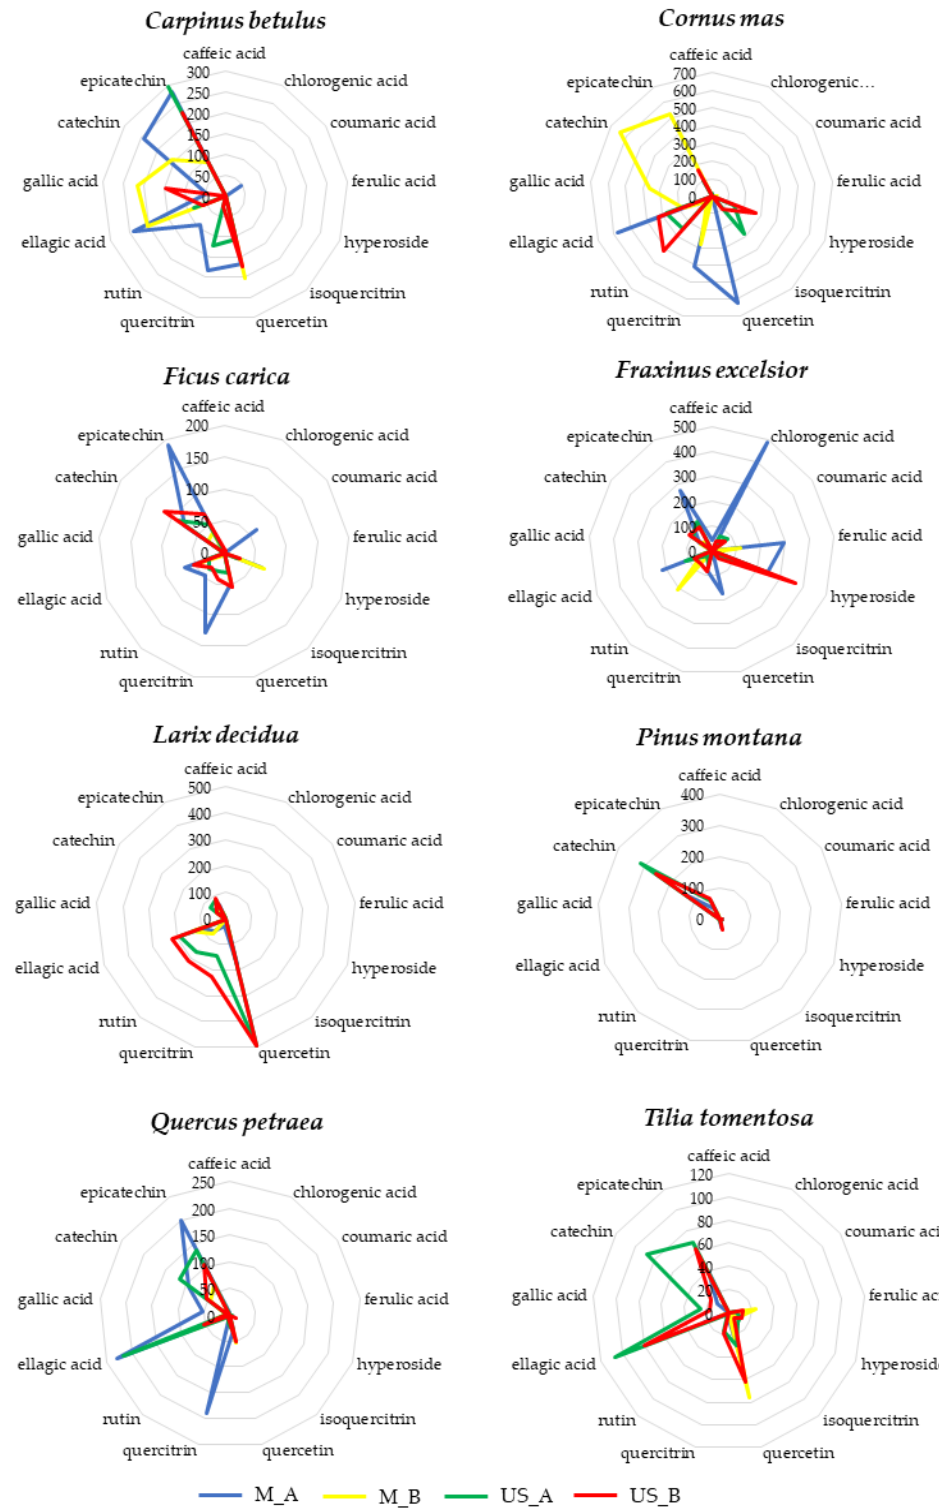
Figure 7. For each botanical species the phenolic composition (ca ff eic acid, chlorogenic acid, coumaric acid, ferulic acid, hyperoside, isoquercitrin, quercetin, quercitrin and rutin, ellagic acid, gallic acid, ( + )catechin and (-)epicatechin) of the 4 di ff erent extracts (M_A: blue line, M_B: yellow line, US_A: green line, US_B: red line) was